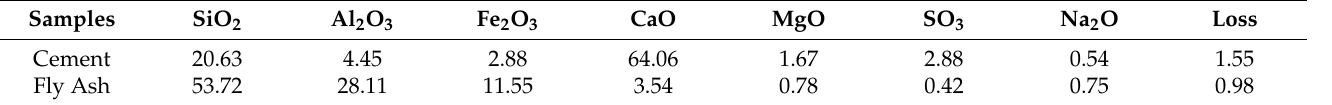
Table 1. Chemical composition of fly ash and cement (by weight,